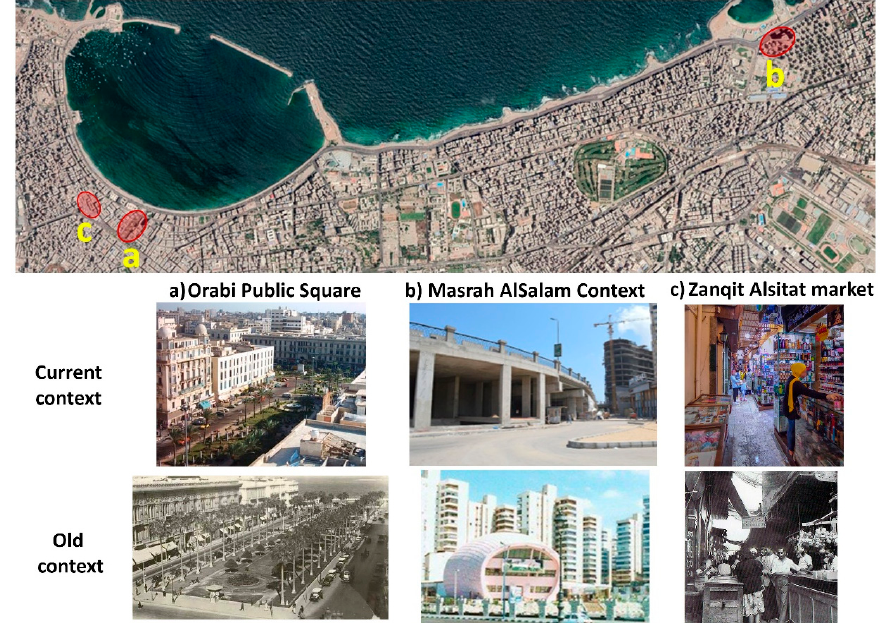
Figure 4. The location of the three studied historic urban landscapes (HULs) within Alexandria. ( a ) Orabi Public Square, upper photo for the current context. Source: F. Hussein. The lower photo for